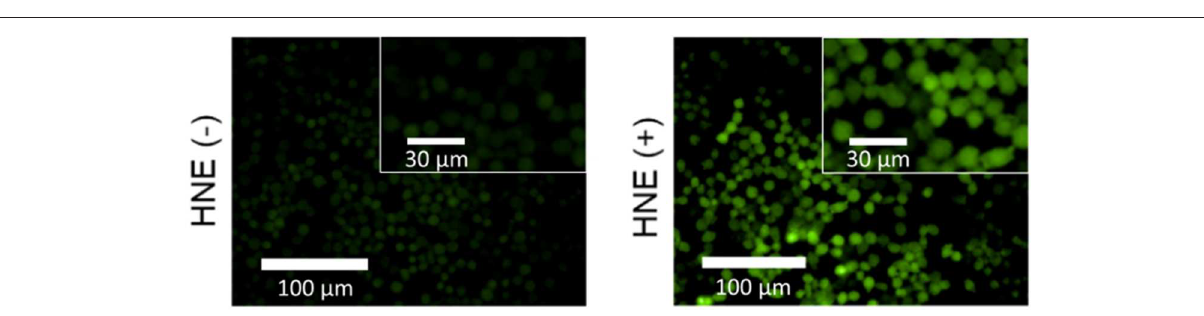
FIGURE 3 | Widefield fluorescence micrographs of RAW 264.7 cells incubated with ACS-HNE/BSA (20/100 µ M) before (–) or after ( + ) addition of human NE (HNE, 4 ng µ L − 1 , 100 µ L); Excitation and emission wavelengths for ACS-HNE are 460–490nm and 500–550nm, respectively. The inset shows magnified sections of the corresponding fluorescence